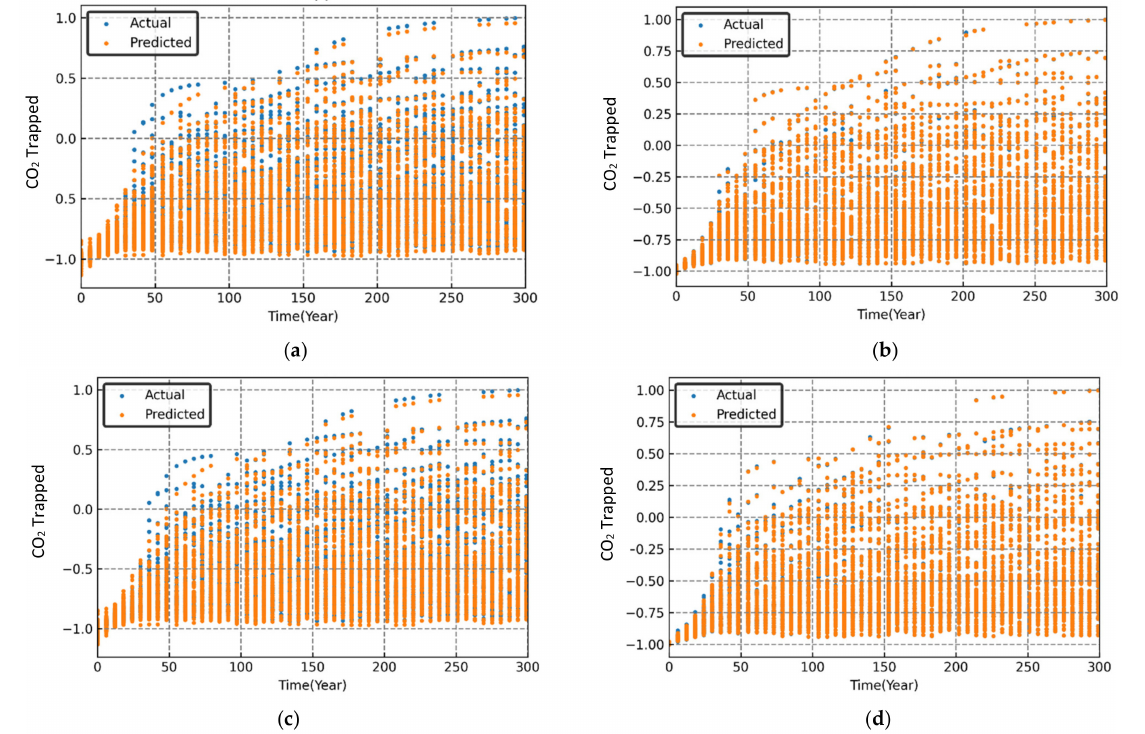
Figure 10. Variation in simulated and predicted trapped CO 2 (normalized) over time for different sets of randomized input parameters. ( a ) MLP; ( b ) RF; ( c ) SVR; ( d ) XGB.